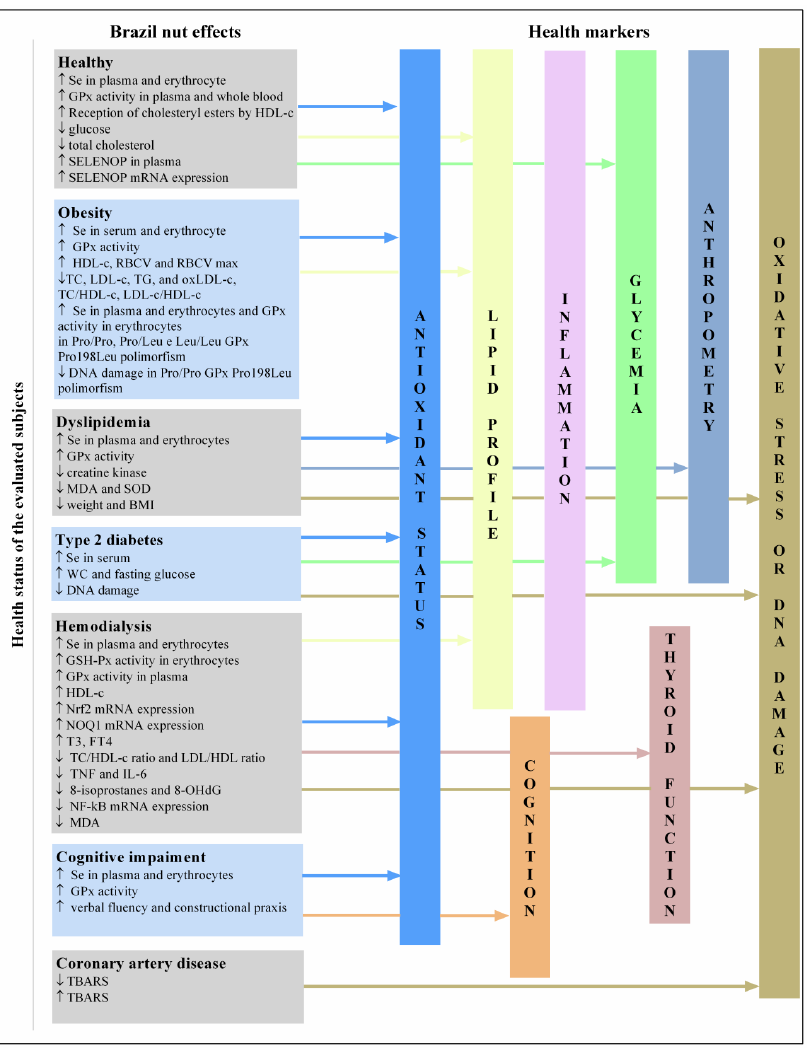
Figure 3. Summary of the effects of Brazil nuts consumption on human health. The effects of regular BN consumption were grouped according to the health status of the subjects evaluated in the studies included in the review. These effects were then linked to a larger category of health markers.